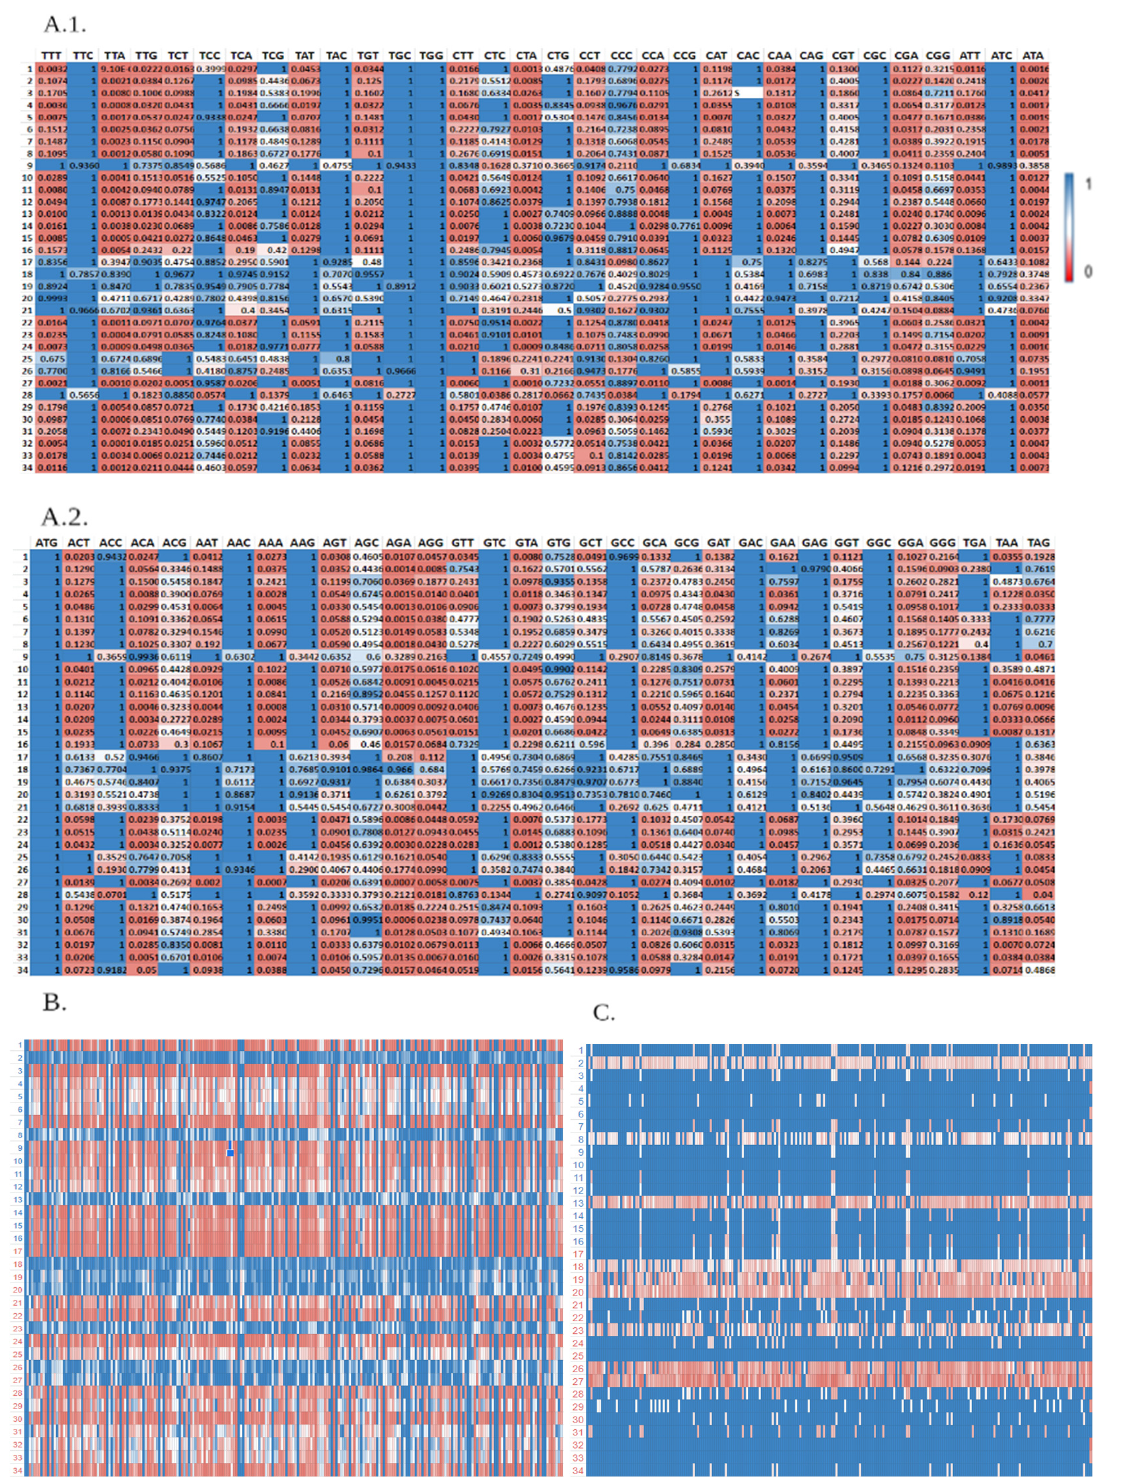
Figure 10. Translation efficiency optimization of the ( A.1 , A.2 ). thaliana microbiome, using the calculated CUB scores of all codons shown in figure ( A.1 , A.2 ), the initial scores of the ZorA gene in ( B ), and the final scores of the gene in C . The names of the organisms represented by the numbers in ( A.1 , A.2 ) and in ( B , C ) are detailed in Tables A1 and A2 respectively.